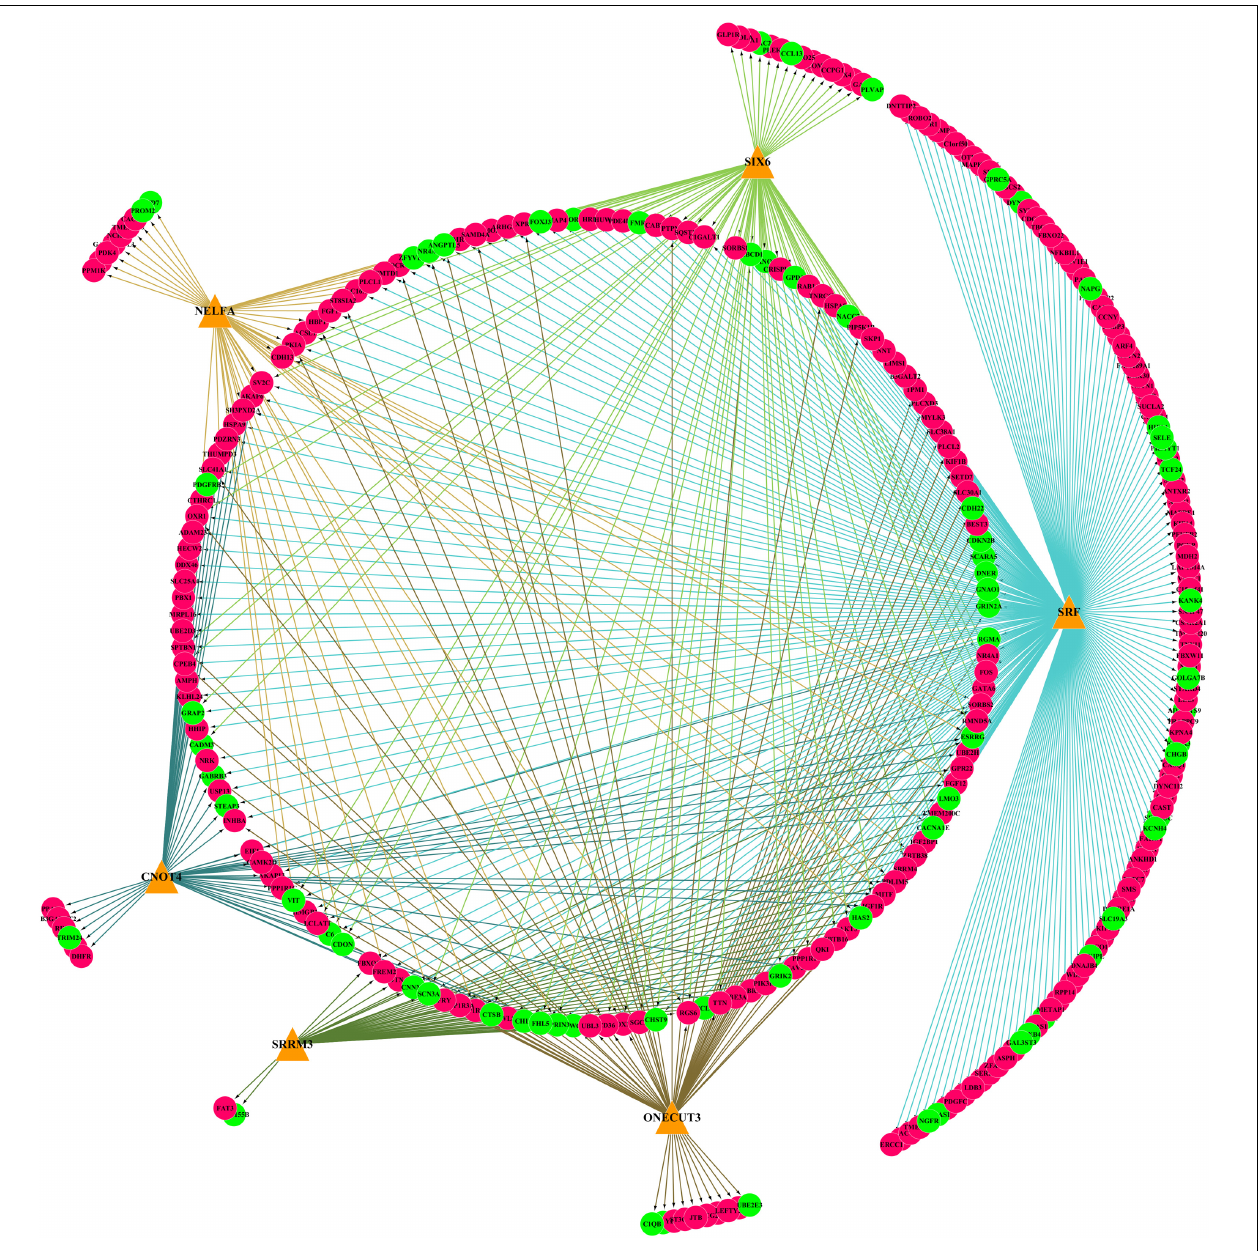
FIGURE 6 | The TF–target regulatory network of differentially expressed genes (DEmRNAs). Orange triangles represent TFs, red circles represent upregulated genes, and green circles represent downregulated genes. TFs, transcription